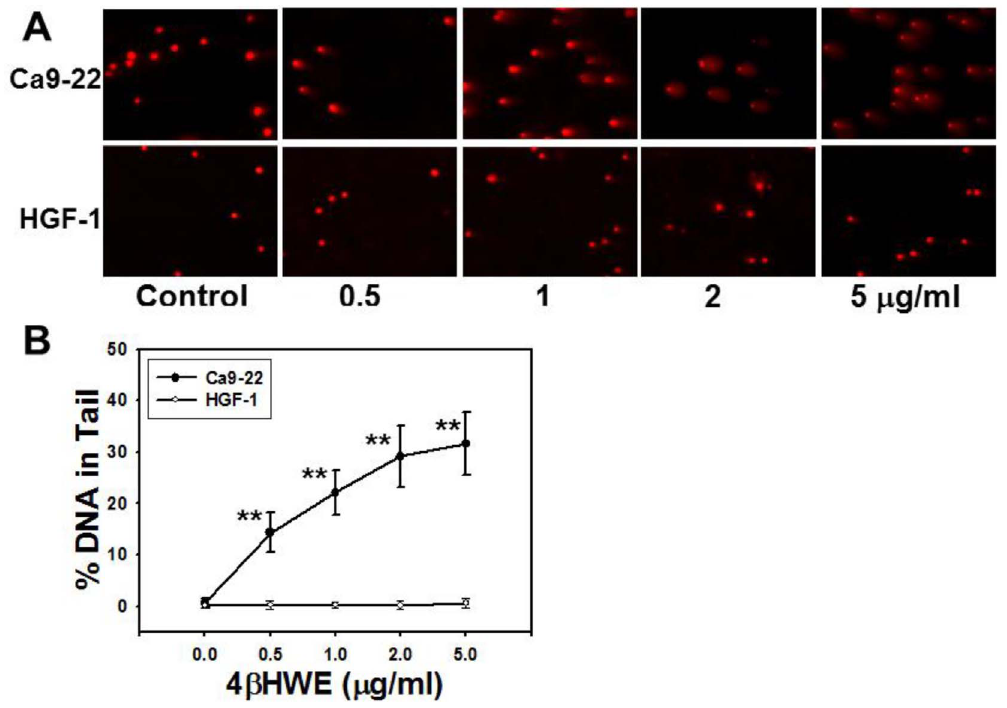
Figure 4. After 4 b HWE treatment, oral cancer Ca9-22 cells and normal oral HGF-1 cells showed different comet-NE based DNA damage profiles. (A) Representative comet PI staining results for cell controls (DMSO) and cells treated with 0.5, 1, 2, and 5 m g/ml 4 b HWE for 2 h. The nuclei appear as red spots, and the tails of the spots indicate the severity of DNA damage after 4 b HWE treatments. (B) Average of the% of tail DNA in 4 b HWE-treated Ca9-22 and HGF-1 cells. Data, mean 6 SD (nuclei=50). Asterisks indicate significant differences between the Ca9-22 and HGF-1 cell lines after treatment with similar 4 b HWE concentrations ( t -test, P , 0.0001**).